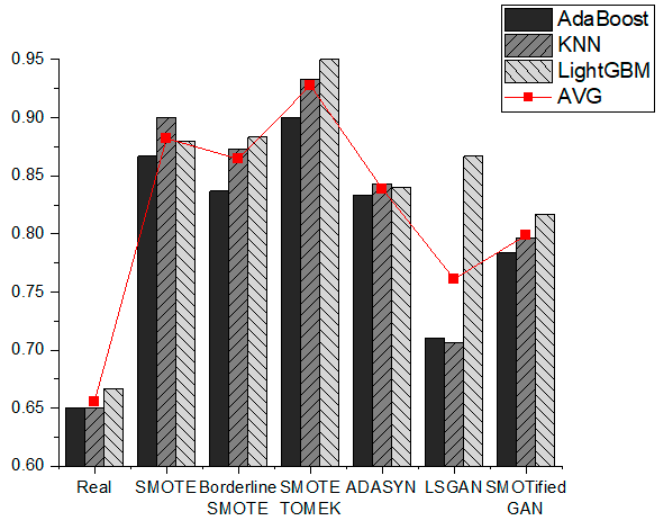
Figure 7. Undersampling and oversampling with FDC recall value.